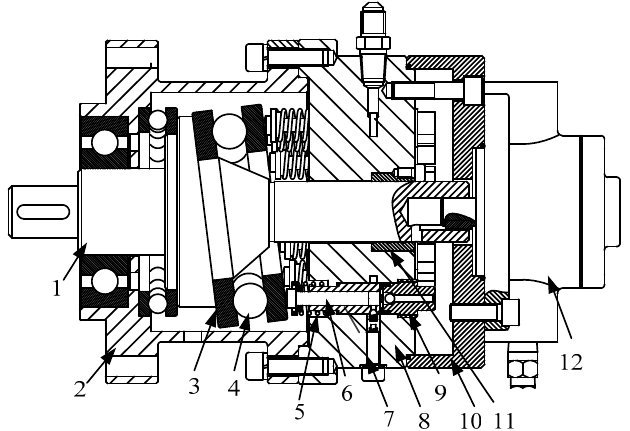
Figure 1. Structural sketch of piston pump. 1—drive shaft; 2—pump cover; 3—swash plate; 4—thrust ball bearing; 5—return mechanism; 6—piston; 7—hydraulic valve screw; 8—hydraulic cylinder; 9—marble seat; 10—lower end cover; 11—copper sleeve; 12—cycloid pump.